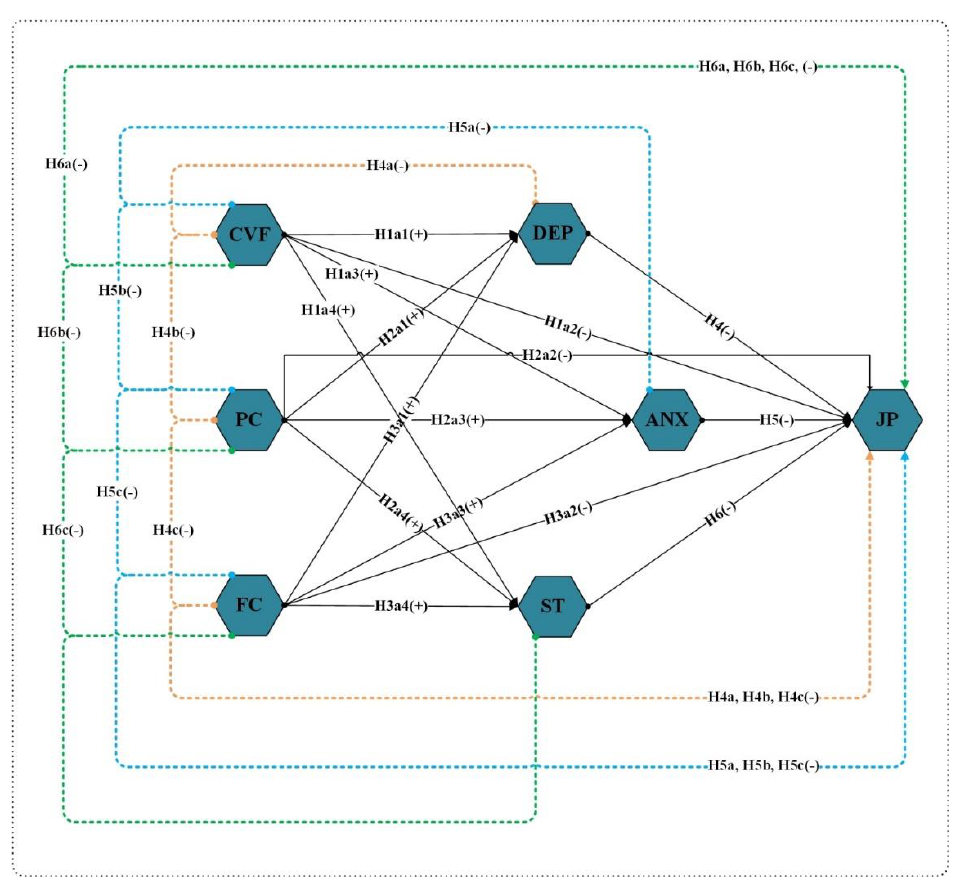
Figure 1. Conceptual Framework. CVF — Fear of COVID-19. PC — Psychological Concerns; FC — Financial Concerns; DEP — Depression; ANX — Anxiety; ST — Stress; and JP — Job Performance.